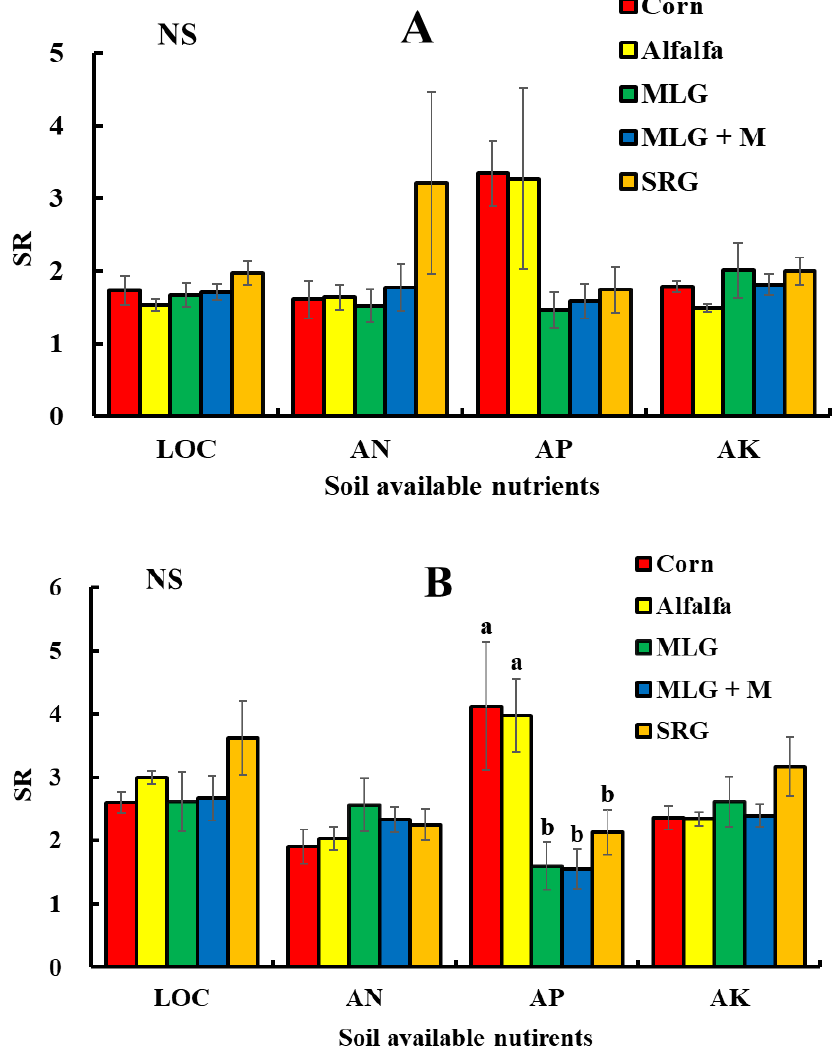
Figure 6. Changes in the stratification ratio (SR) of 0–10 / 10–20 cm ( A ) and 0–10 / 20–30 cm ( B ) under different land uses. The bars represent standard errors. Values without a common letter within land use treatments differed according to the LSD test ( p < 0.05). NS = not significant among different land uses.